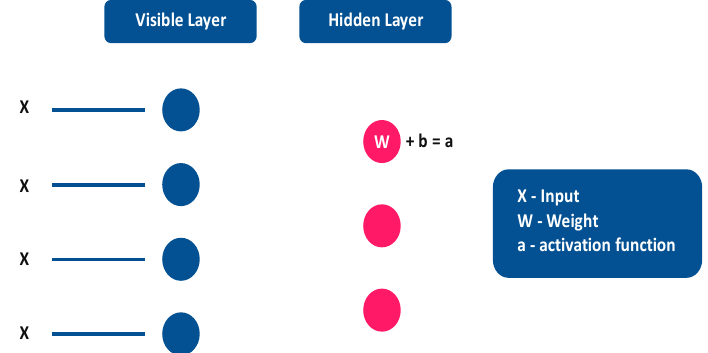
Figure 10. A representation of one input path in RBM